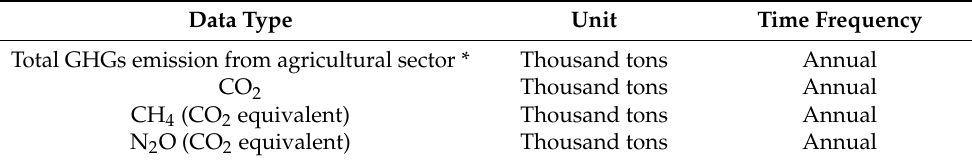
Table 1. Type of collected